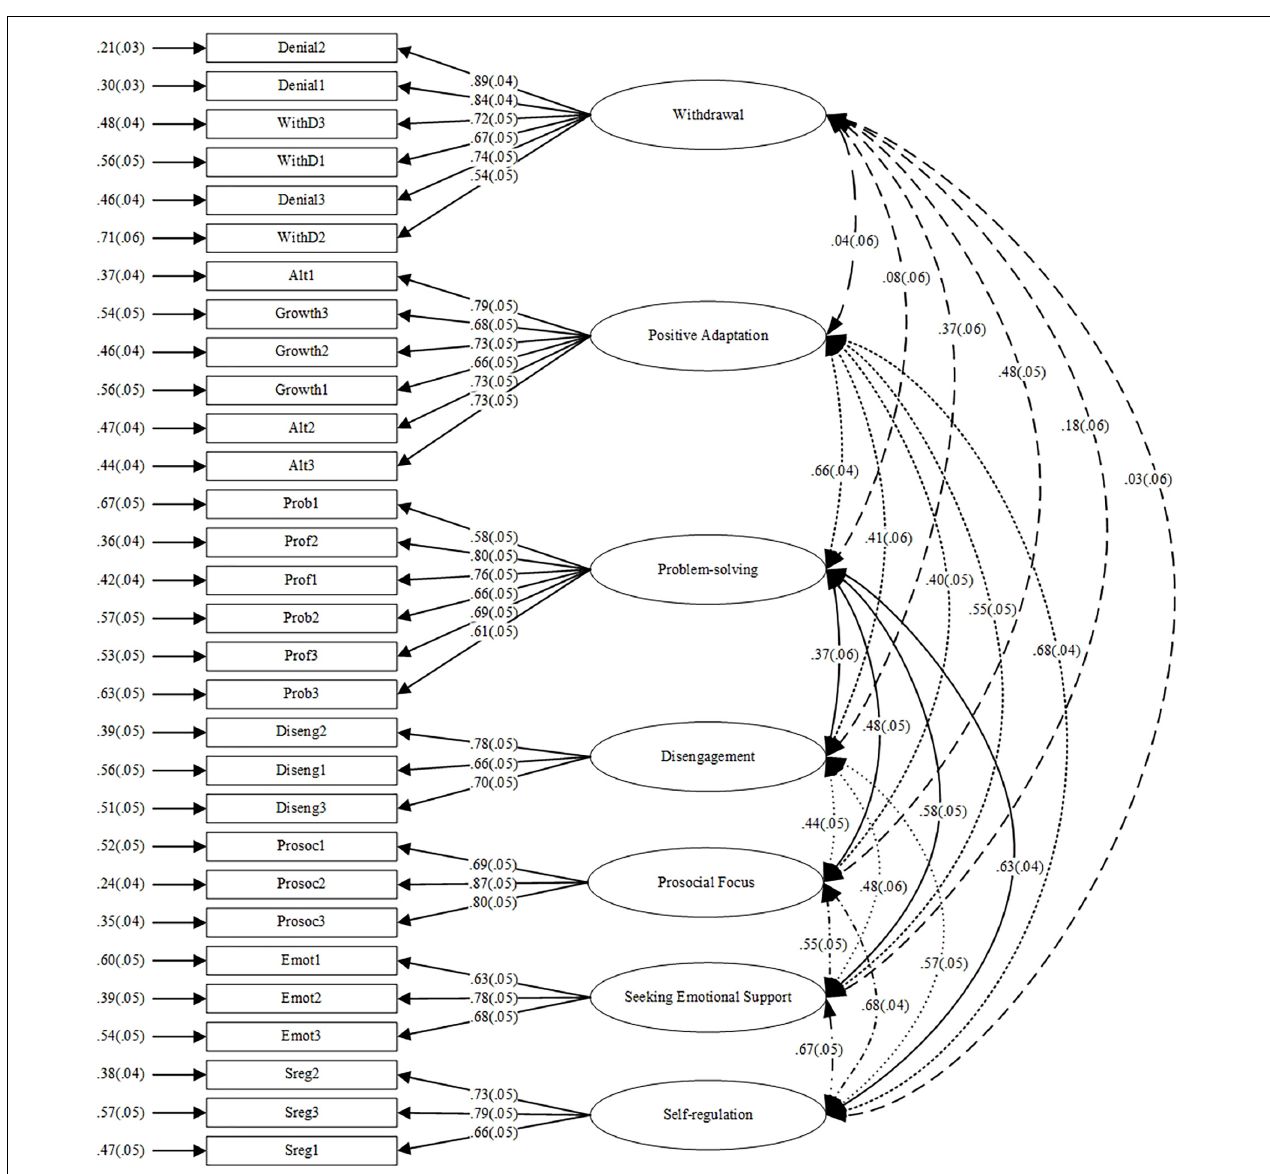
FIGURE 1 | Path diagram for the seven-factor model of the coping strategies scale